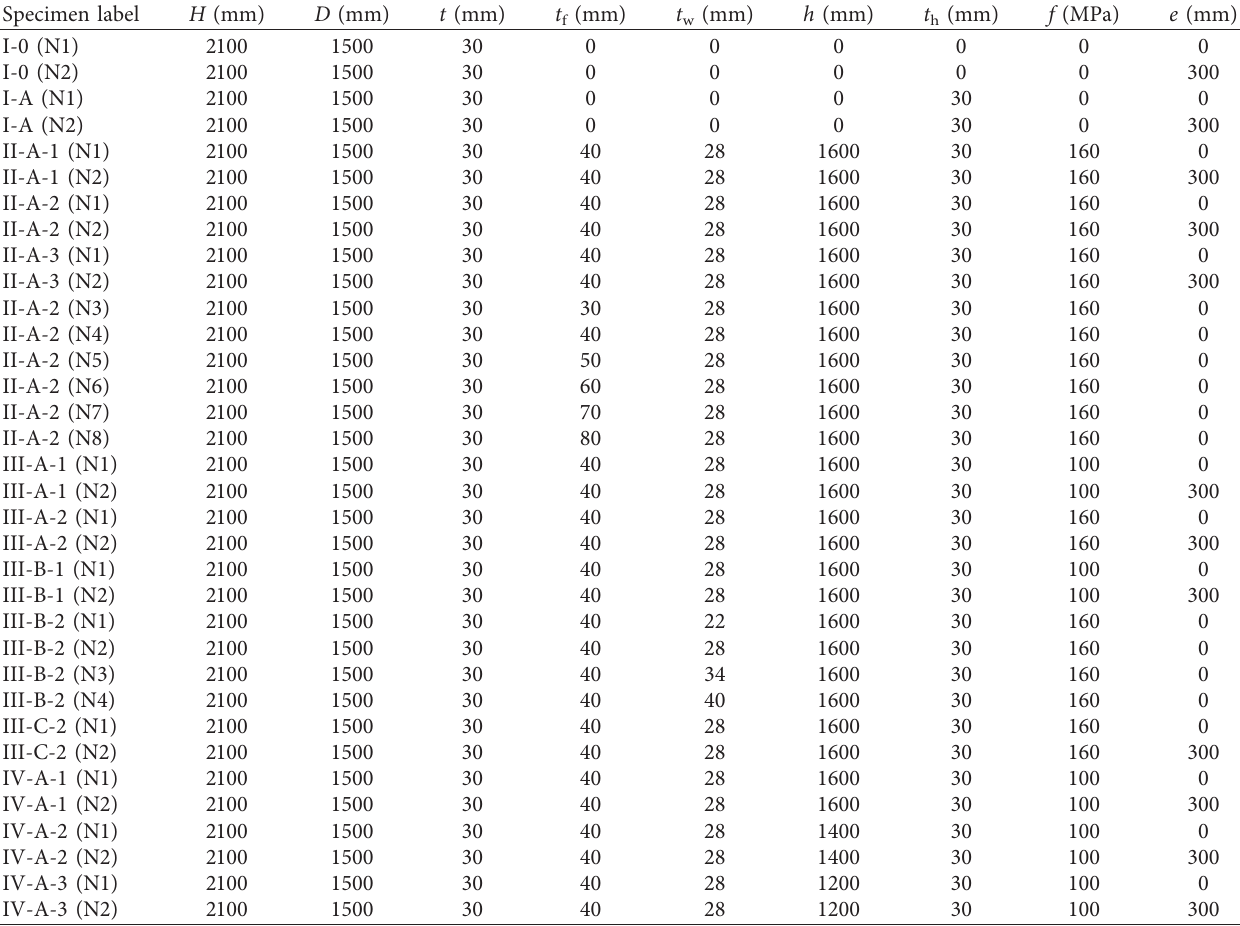
Table 4: The design parameters of numerical specimens.